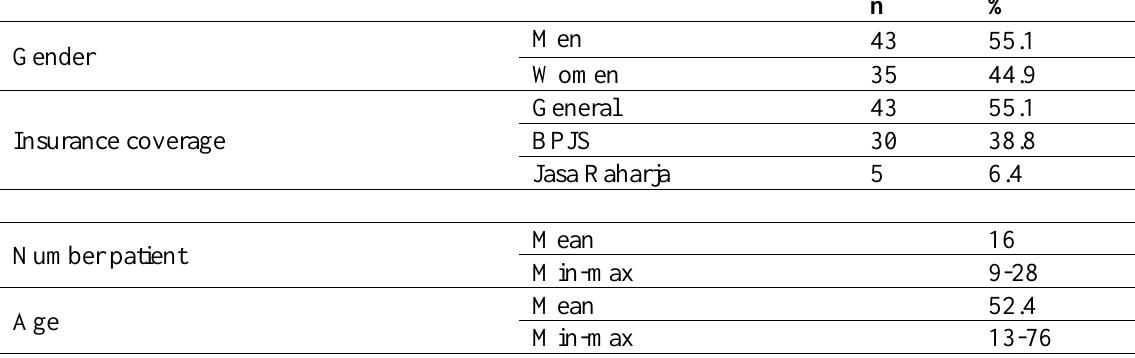
Table 1. Demographic characteristic of the respondents